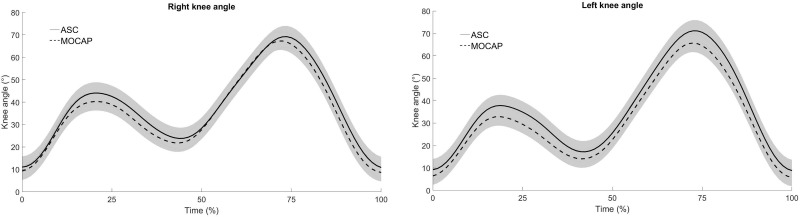
Mean curve of the angular variation, of the right and left knee, of 14 stride cycles in one running trial (40 meters).Vicon (dashed line) and GoPro (continuous line).